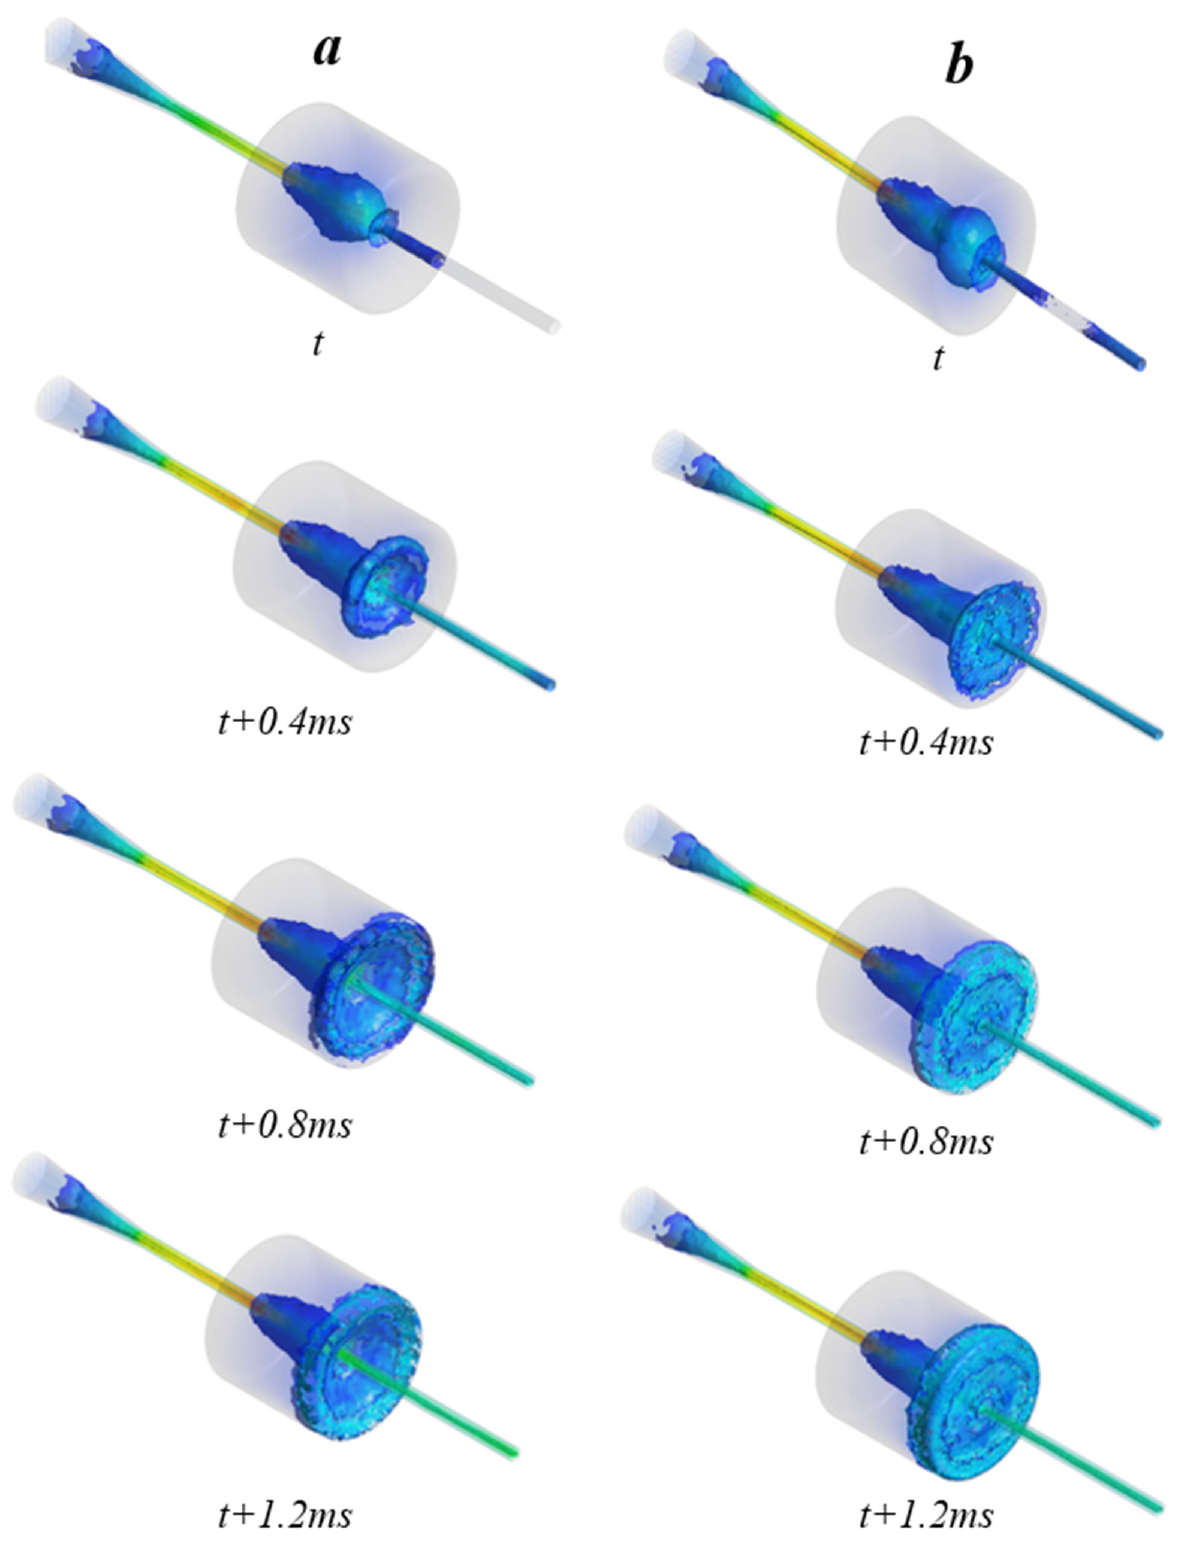
Figure 5. Variations of the velocity vortex field inside the two chambers: ( a ) Helmholtz wave-elimination chamber; ( b ) traditional wave-elimination chamber.